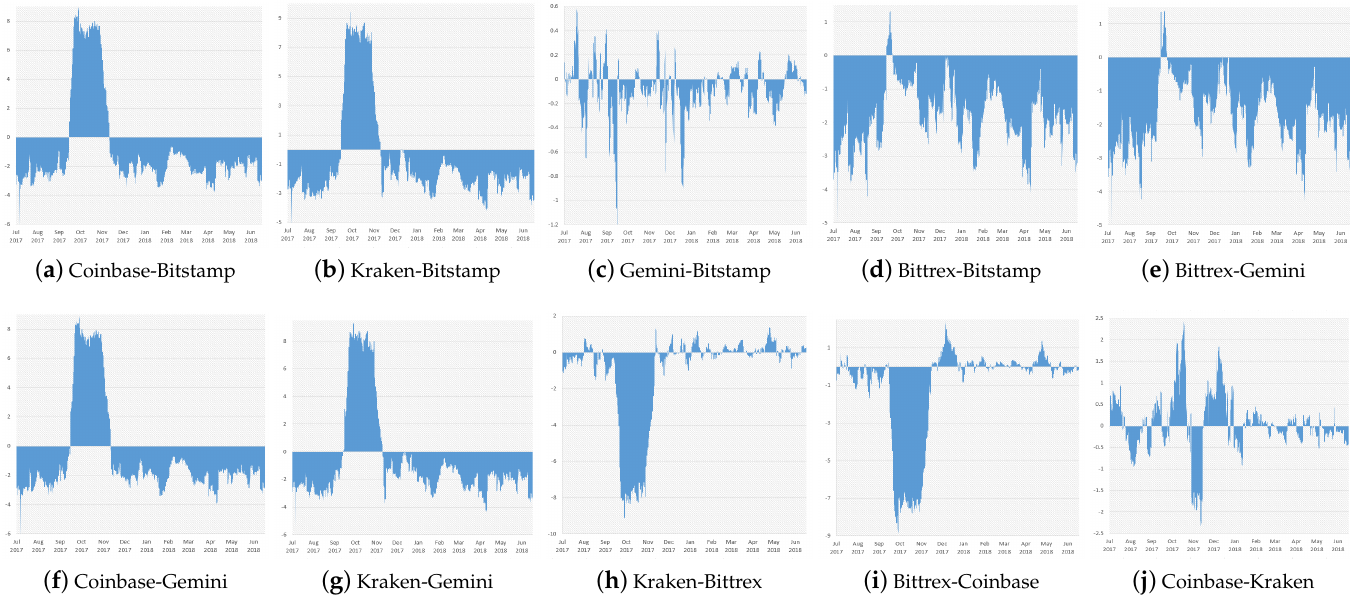
Figure 5. Net Pairwise Spillover Indexes (NPSI). Note : The figure illustrates the net pairwise return spillover indexes. The rolling window set for the estimations is 336 h—corresponding to two weeks. Values are expressed in percentage